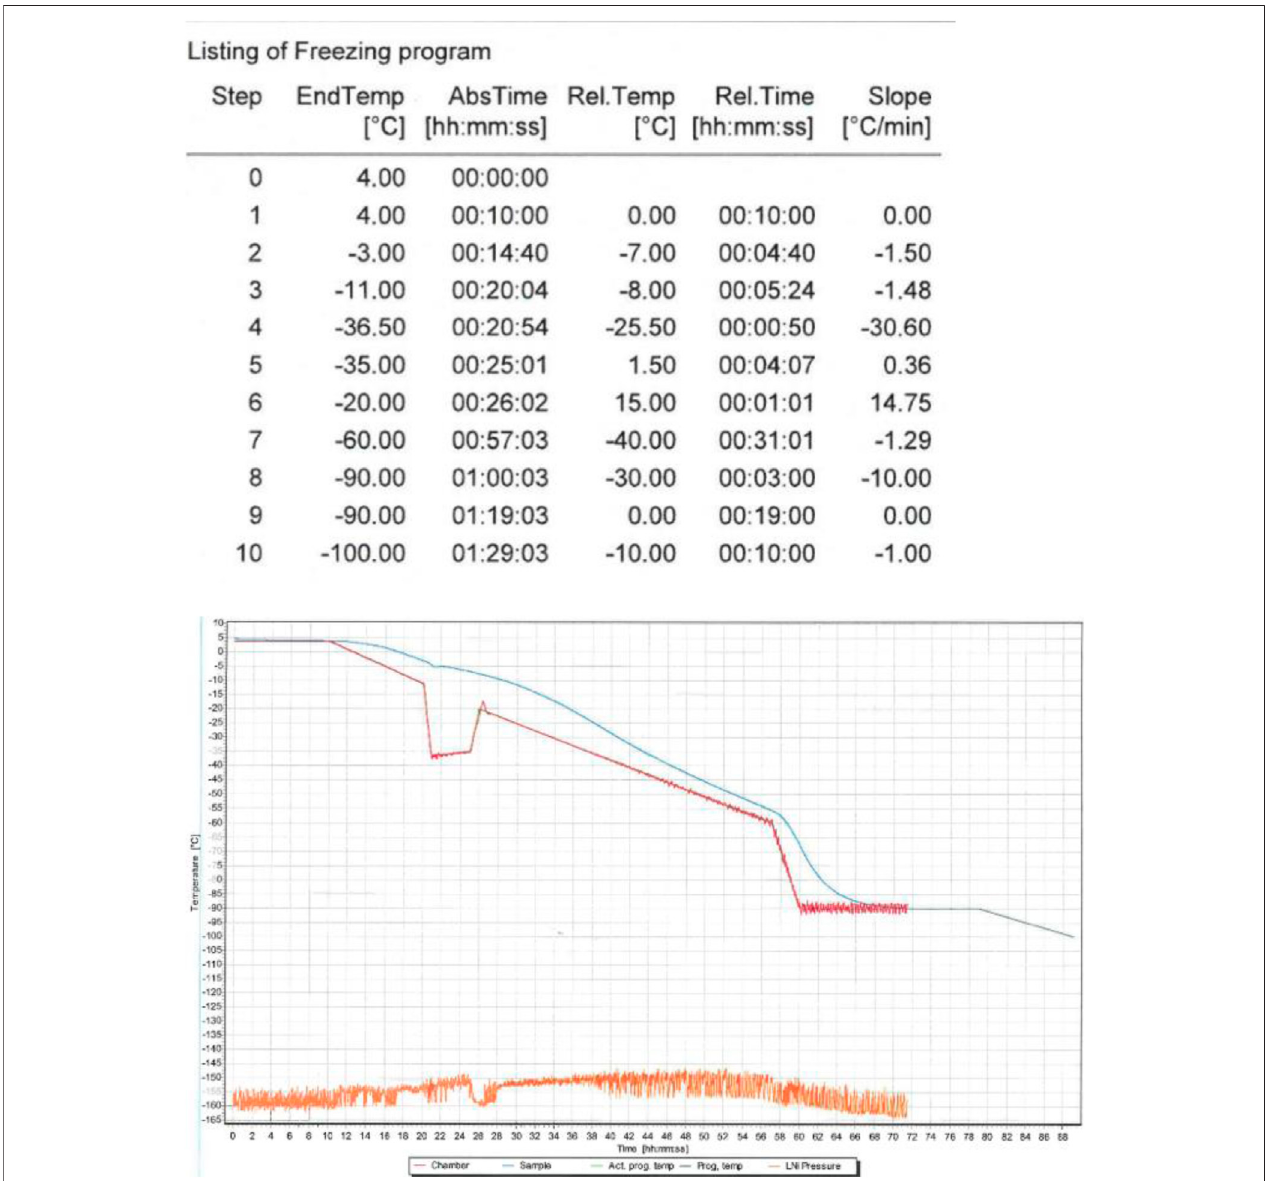
FIGURE 1 | The freezing procedure was implemented using the IceCube device. The freezing program started at 4 ° C and fi nished at − 80 ° C. After freezing AT- MSCs were transferred to cryogenic containers ( − 170 ° C).